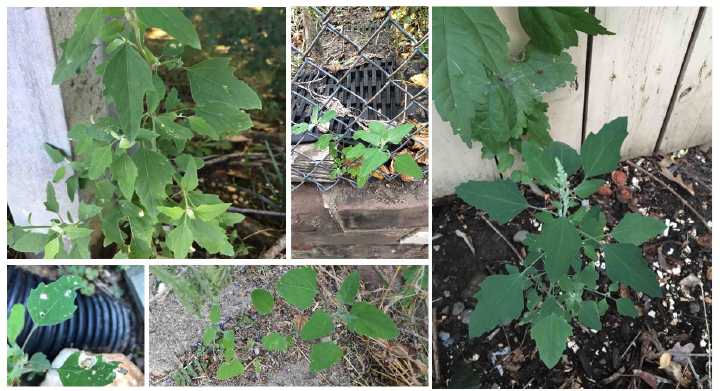
Figure 11. Examples of correctly identified lambsquarters as submitted by users from the DMV, 1 September 2019. Courtesy of Brianna